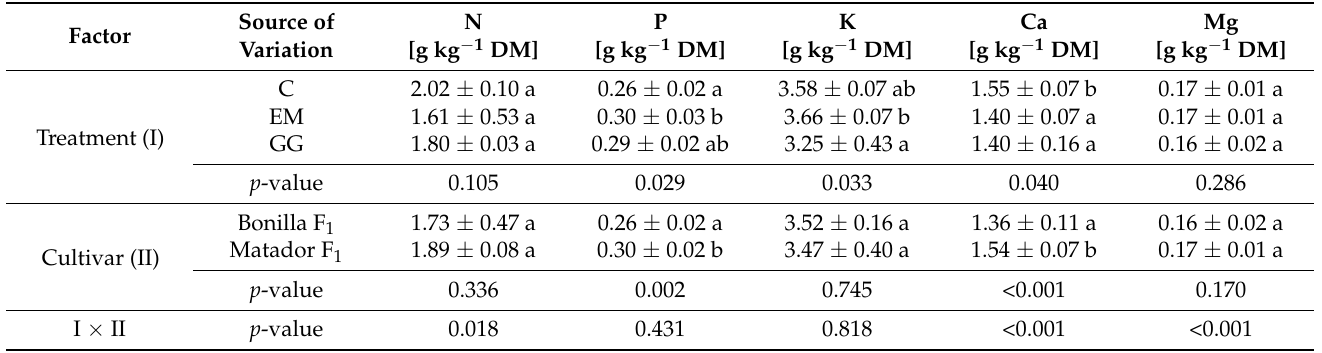
Table 7. Macronutrient content of shallot